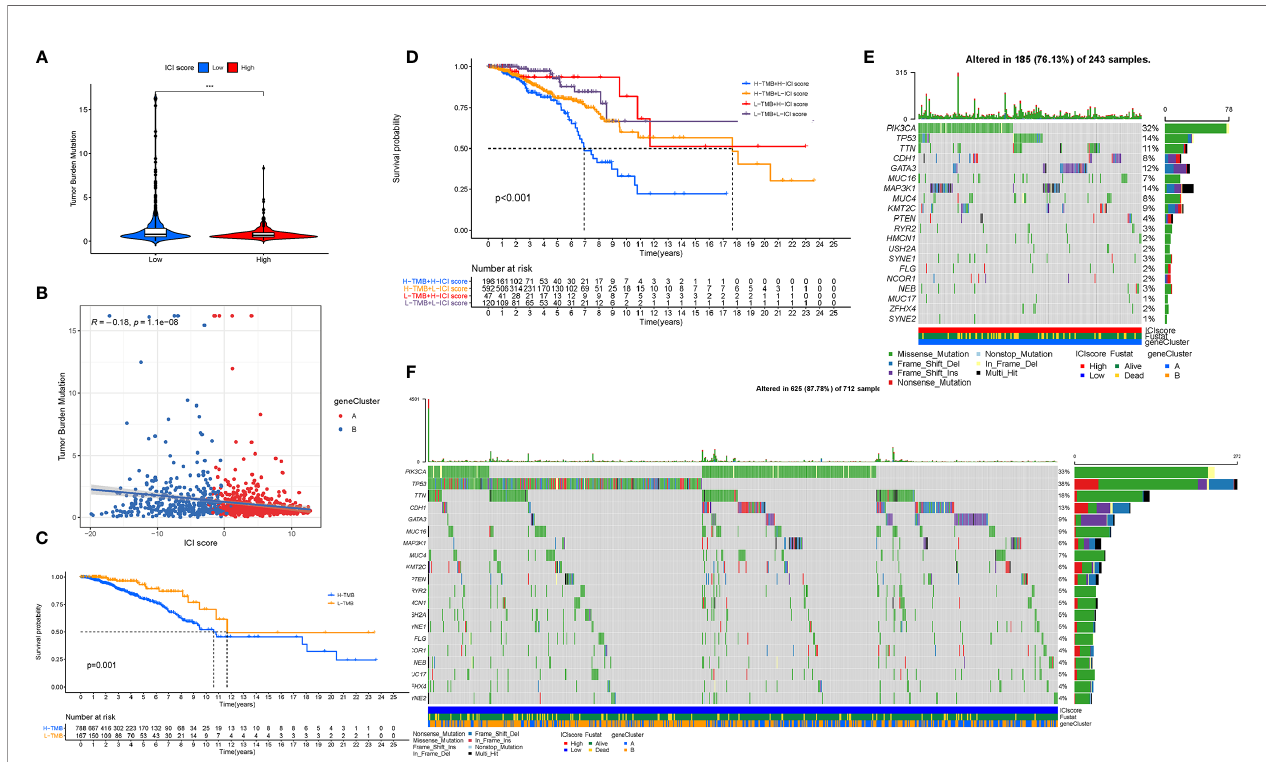
FIGURE 10 | The Correlation between the ICI Score and TMB. (A) Difference of TMB between patients from the low-/high-ICI score subgroups. (B) Scatterplots depicting the negative correlation between the ICI scores and TMB. (C) Kaplan-Meier curves for the high and low TMB groups. (D) Kaplan-Meier curves for patients strati fi ed by both TMB and ICI scores. The oncoPrint was constructed using the high ICI scores (E) and low ICI scores (F) . The asterisks represented the statistical p value (***P <